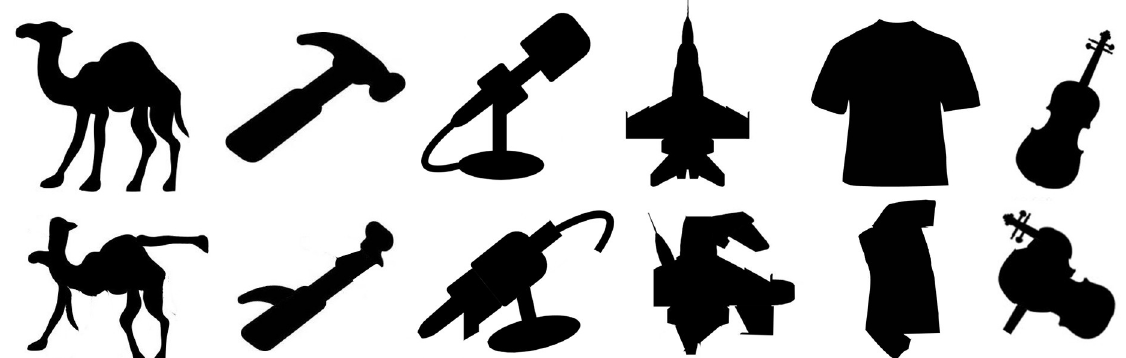
Fig 23. Stimuli used in Experiment 5a. Top row: the original silhouette images, all correctly classified by VGG-19 (appearing in top-five). Bottom row: Scrambled images on which the network was tested.